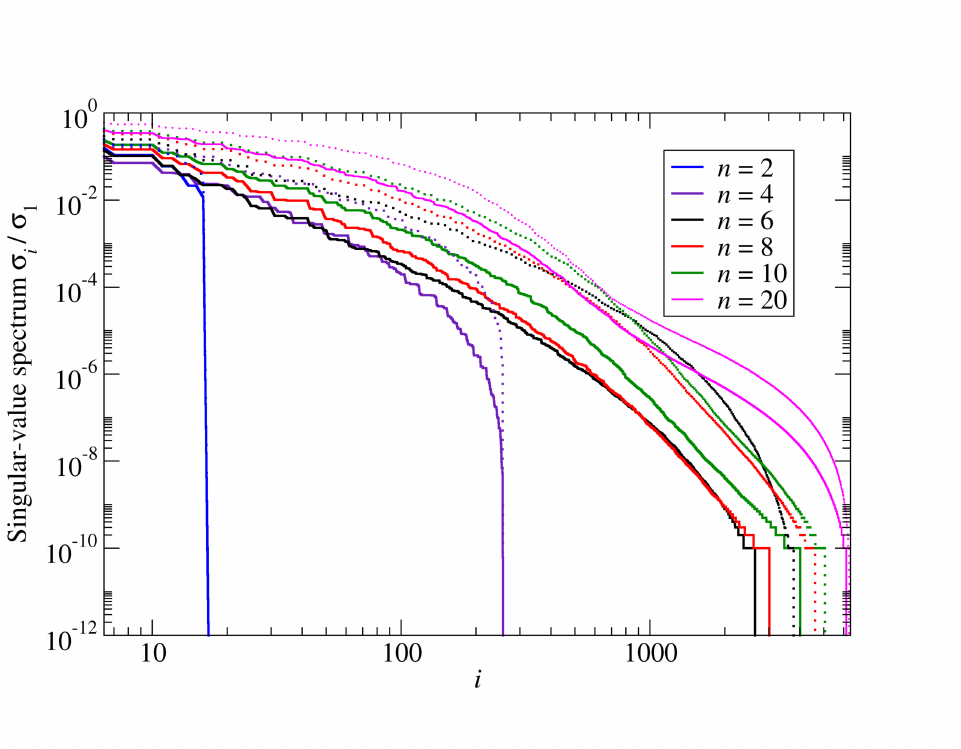
Figure 7 . Singular-value spectrum obtained by the Grassmann BTRG (solid curves) with D = 80 and n = 2 , 4 , 6 , 8 , 10 , 20 . As in the figure 6, dotted curves represent the results provided by the Grassmann Levin-Nave TRG with D = 80 . The same color corresponds to the same renormalization step n